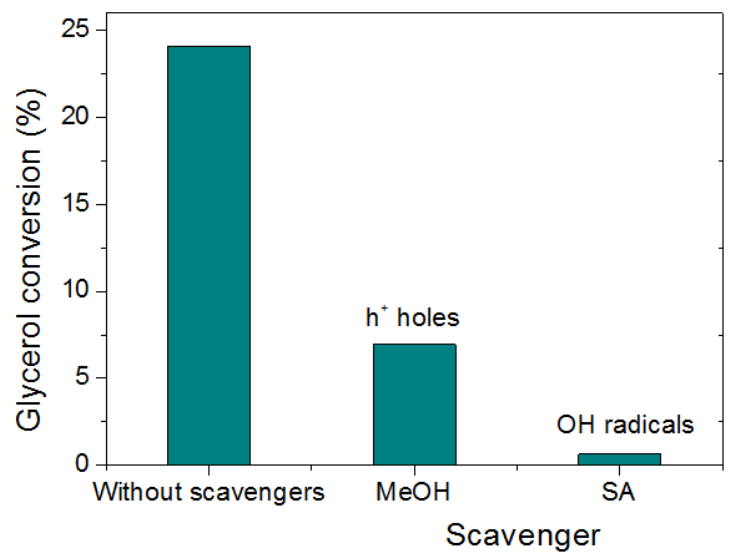
Figure 20. Percentage of glycerol converted in the presence of radical and hole scavengers. Table 6. Comparison of accumulation rate of glyceraldehyde (GCD) and formaldehyde (FD) with TiO 2 , Cu/TiO 2 and other metal-decorated TiO 2